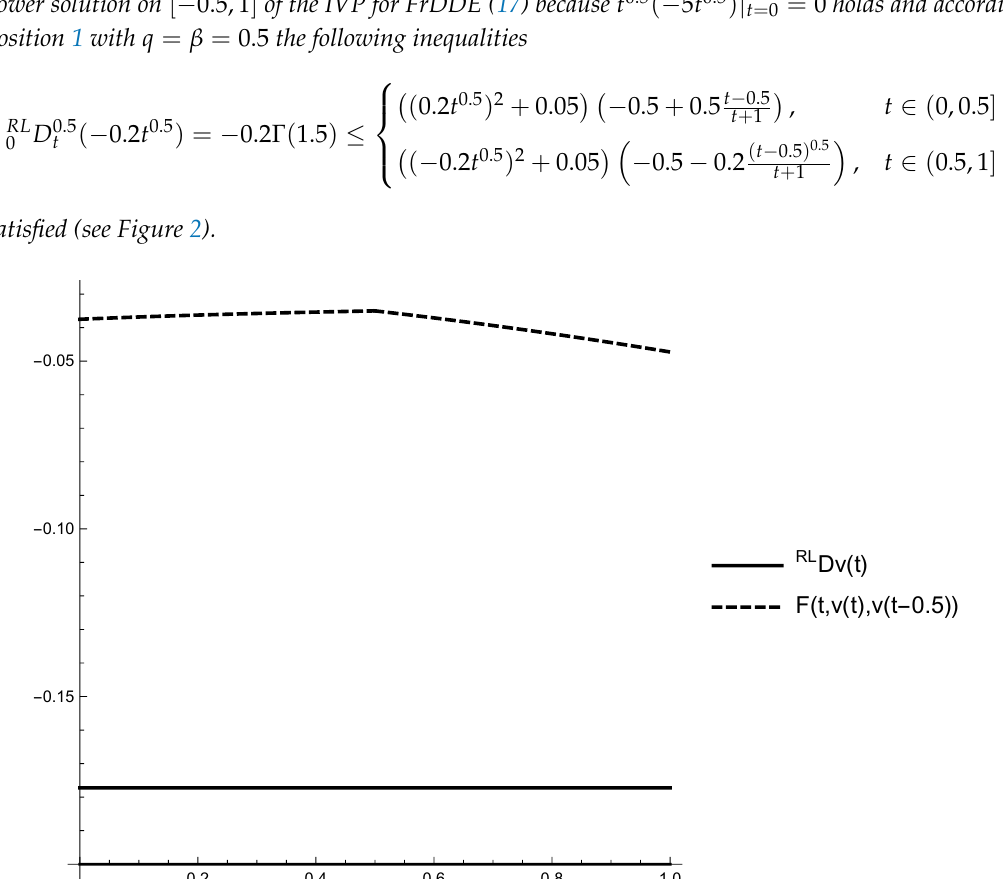
Figure 2. Graphs of the fractional derivative of the functions v ( t ) and the right side part of the equation on [ 0,1 ]